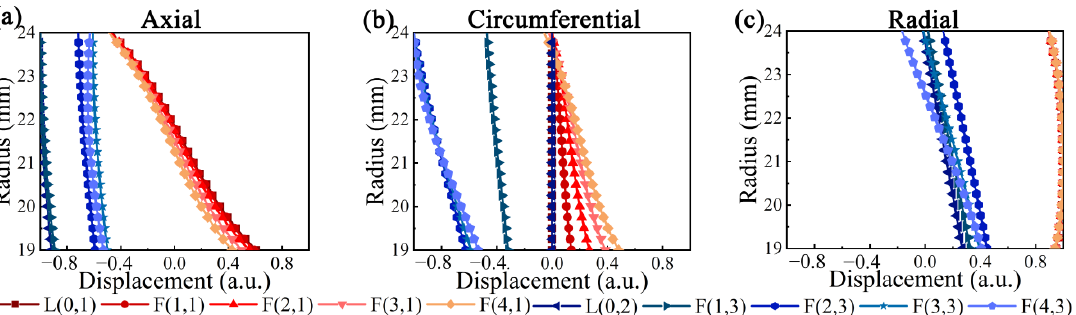
Figure 4. Normalized ( a ) axial, ( b ) circumferential and ( c ) radial displacement distributions of the L(0,1), F( n ,1), L(0,2) and F( n ,3) UGWs (1 ≤ n ≤ 4) at 110 kHz.